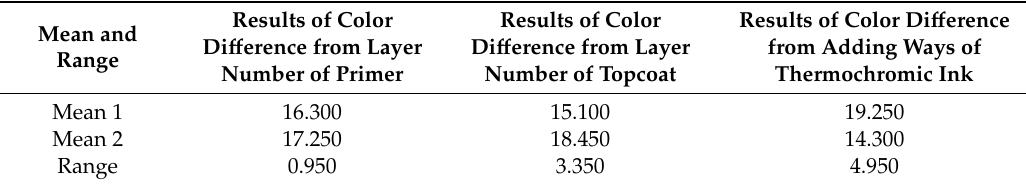
Table 4. Range of the color di ff erence of coating.